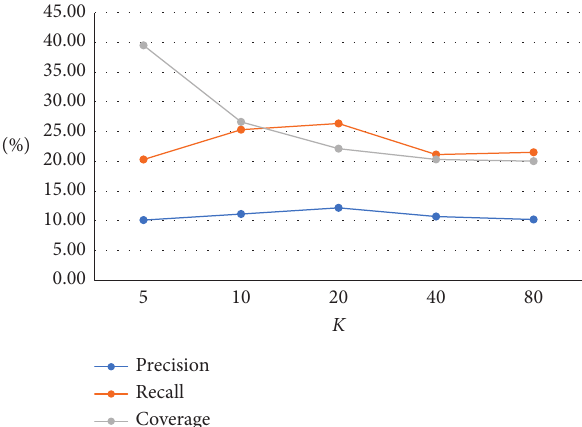
Figure 9: Based on the communication method, user similarity calculation is performed under multiple K